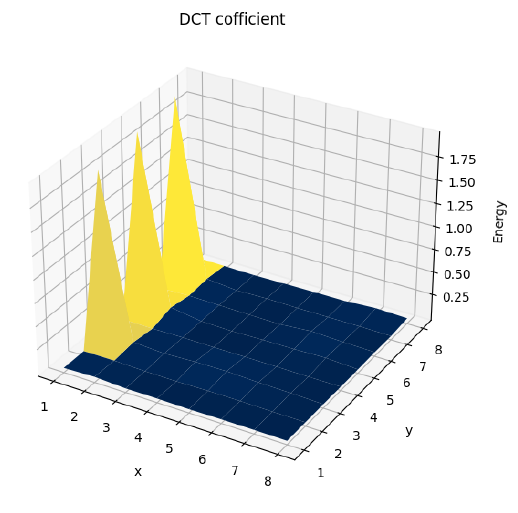
Figure 16. DCT energy 3D plot of the